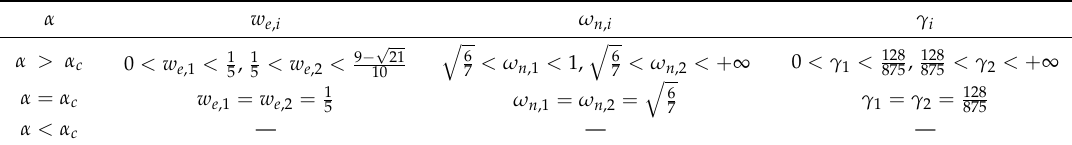
Table 2. Static position, fundamental frequency and DC voltage corresponding to extreme point C 1 and C 2 .